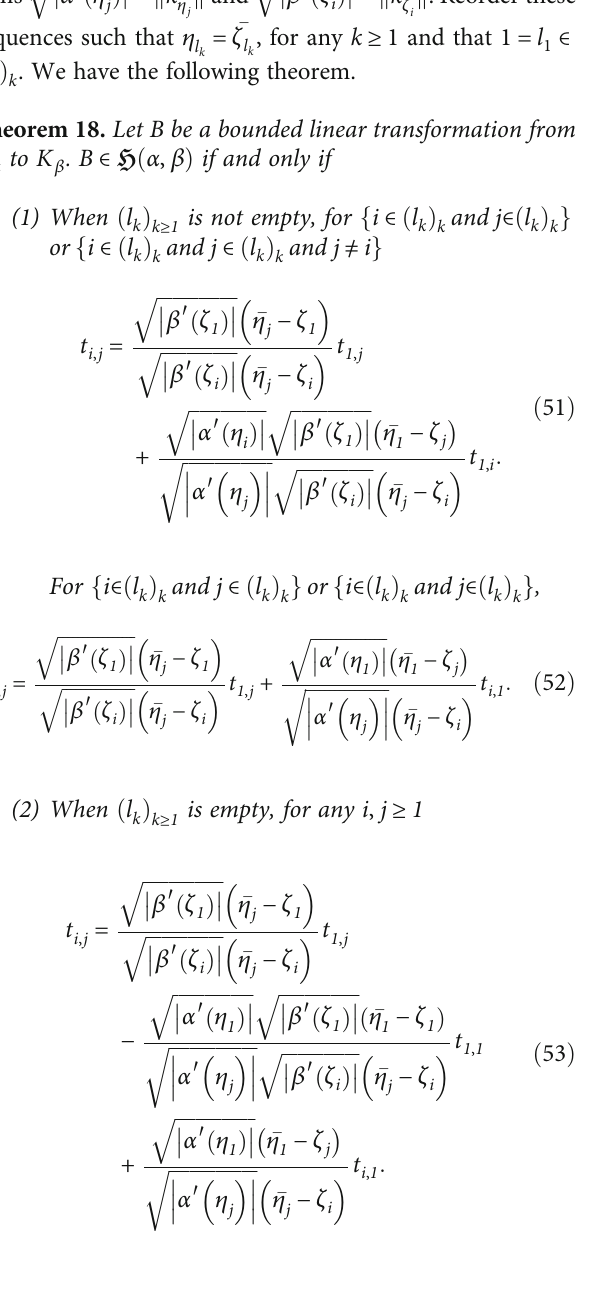
q ffiffiffiffiffiffiffiffiffiffiffiffiffiffiffi ffiffiffiffiffiffiffiffiffiffiffiffiffiffiffi Þj j α ′ ð η j